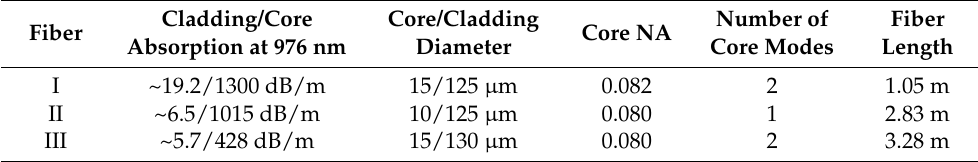
Table 1. Parameter values of the single-frequency fiber